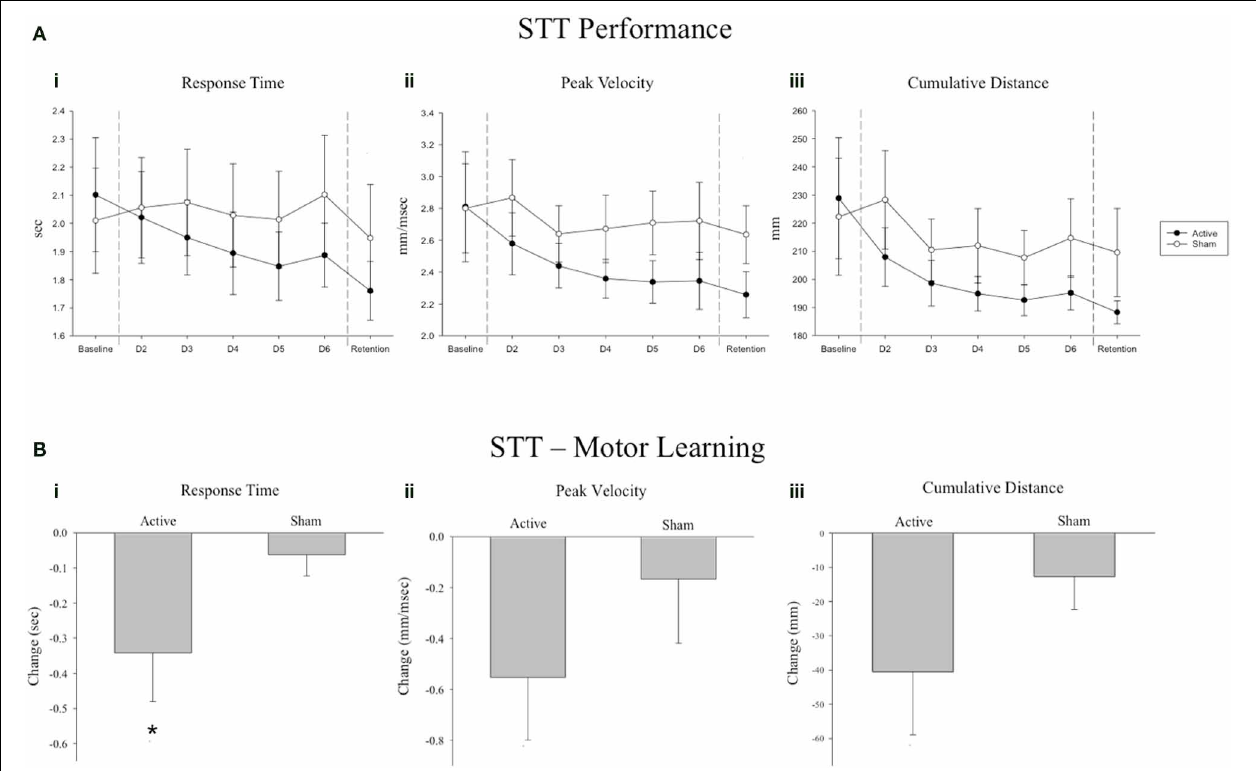
FIGURE 2 | (A) Serial tracking task (STT) mean performance values across all 7 days of the experiment for the Active and Sham groups. A significant Group ∗ Day interaction was observed for (i) Response Time, (ii) Peak Velocity and (iii) Cumulative Distance tracked ( p ≤ 0 . 044). (B) Change scores from baseline to retention for the Active and Sham groups. Negative change scores